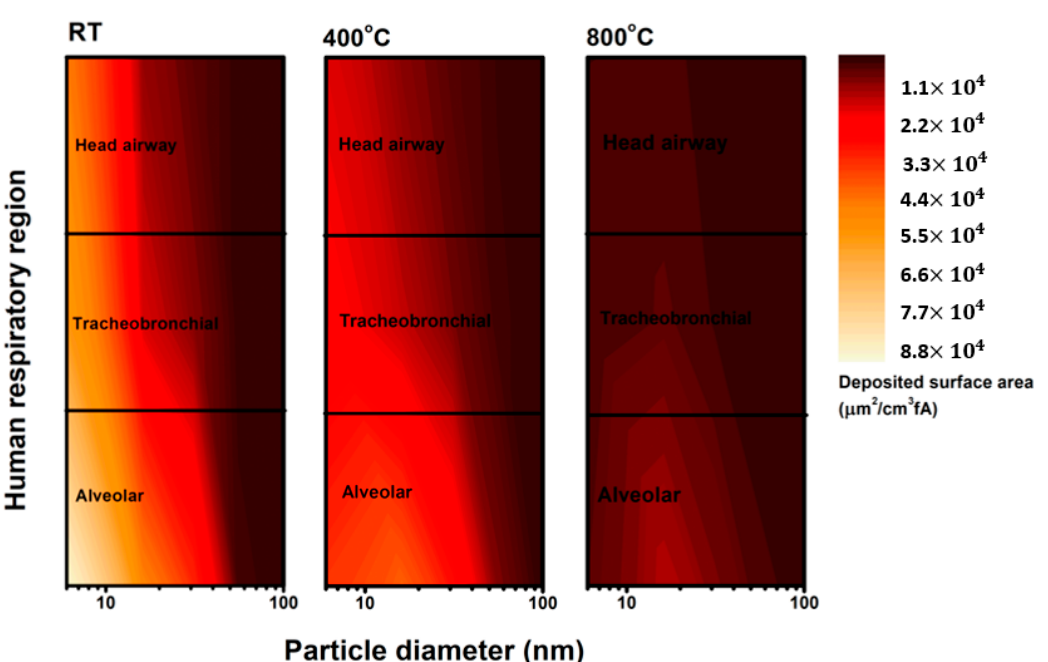
Figure 6. Deposited surface area distributions of aBC in three regions of the human respiratory tract, as predicted based on the electrical current recorded by ELPI+.